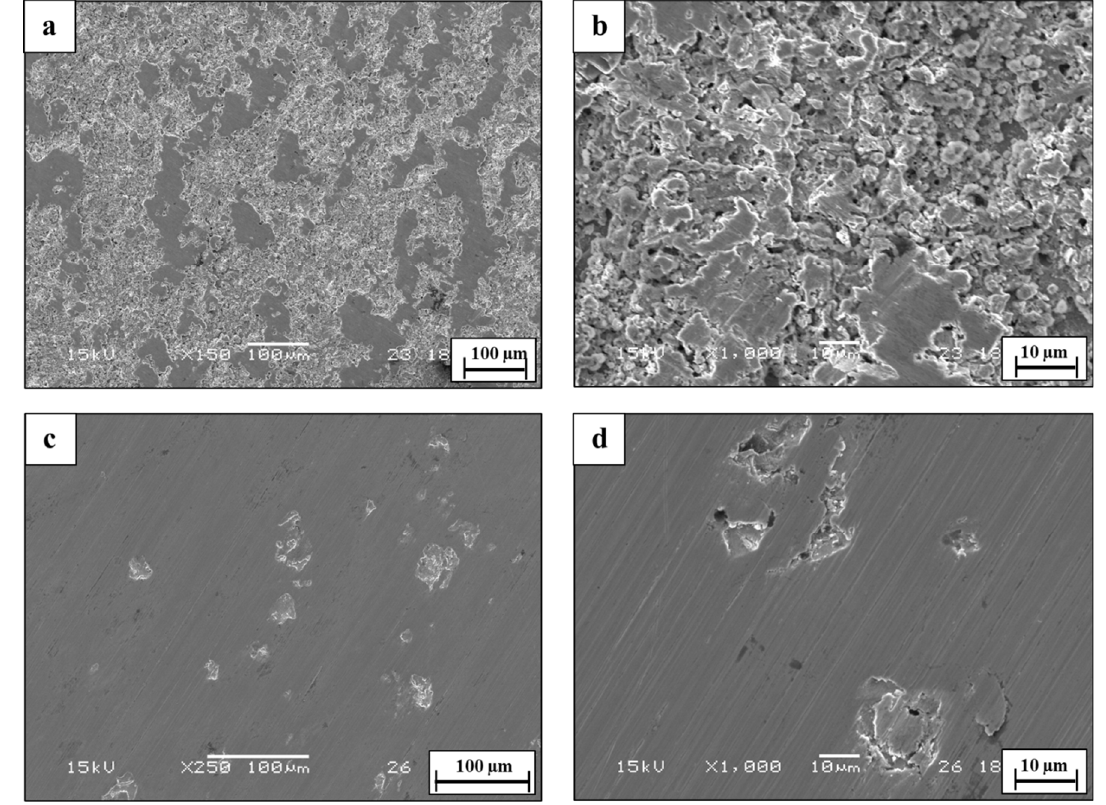
Figure 8. General view of pitting corrosion in tested alloys after immersion test in 1 M HCl solution for 100 h. ( a , b ) WLAM 316L alloy; ( c , d ) AISI 316L alloy. Table 1. The pitting density and pitting factor of WLAM 316L and its counterpart AISI 316L alloy in 1 M HCl solution.